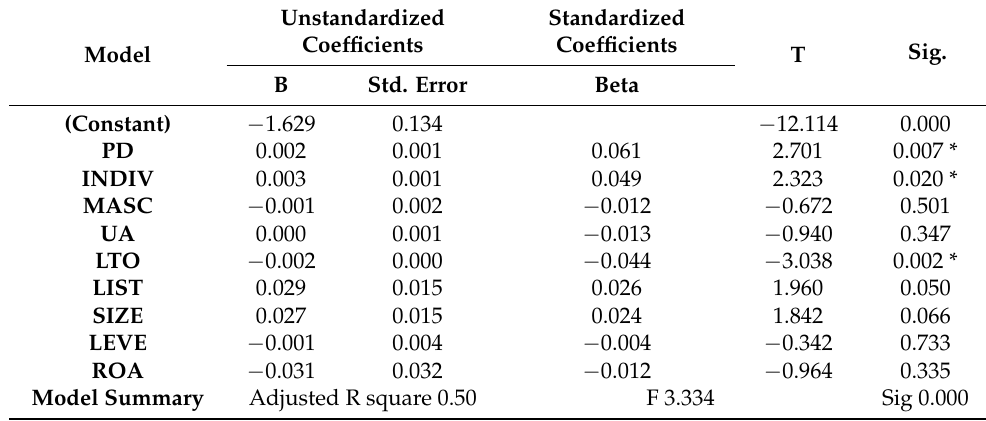
Table 6. Model 3: Results with alternative definitions of cash holdings.